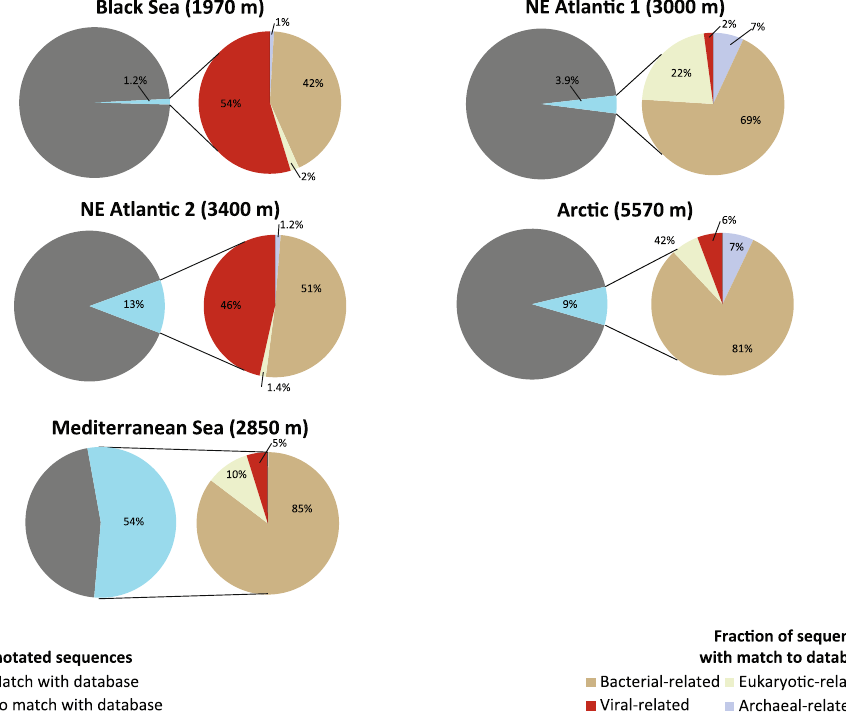
Figure 3. The pie charts on the left show the contributions of the identified sequences to the total sequences obtained from the pyrosequencing analysis of the five viromes (MG-RAST, RefSeq database, 10 − 5 E-value cutoff). The cross sections of the pie charts on the right show the contributions of the sequences associated with viruses and to the different domains of